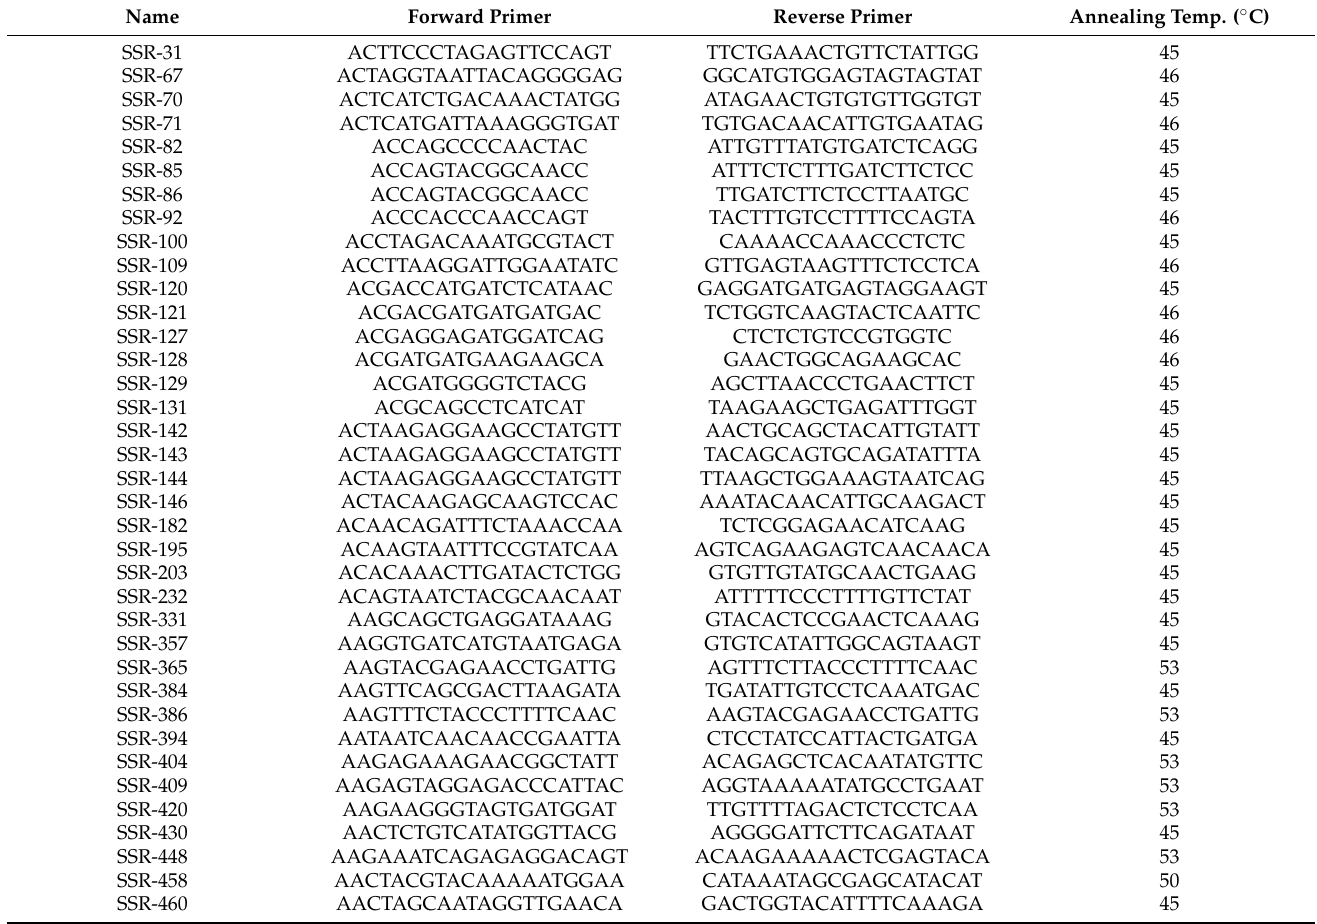
Table 6. Primer information of the 37 SSR markers used in this